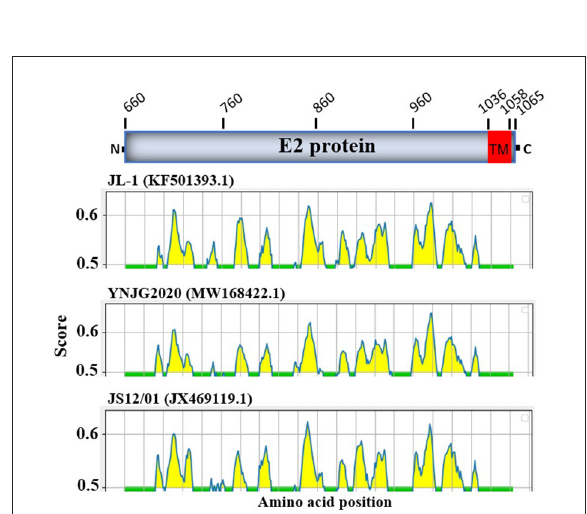
FIGURE5 Linear B cell epitope map of the full-length E2 protein of BVDV. Linear B cell epitope distribution in E2 protein were predicted using the BepiPred-2.0 server. The numbers indicate the amino acid position relative to the full-length polyprotein of BVDV 1 strain JL-1 (GenBank: KF501393.1, Protein ID = AII17592.1). E2 protein is aa 660-1065. The X-axes represents the amino acid position, while the Y -axes represents the residue score, which is also relative to the diagram on the top. The predicted epitopes are indicated in